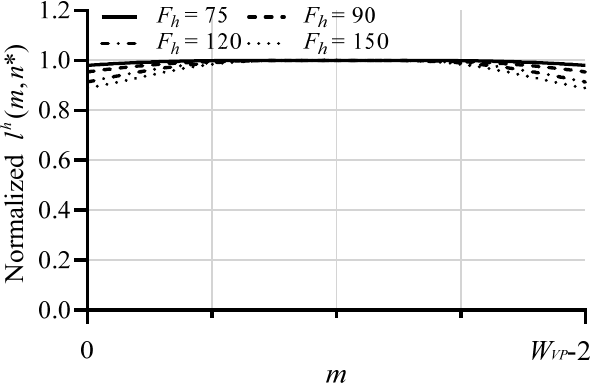
Figure 14. Normalized l h ( m, n * =H VP /2) when the proposed UV surface is used with the optimized values of r and u is modified by the mapping function g(u) .